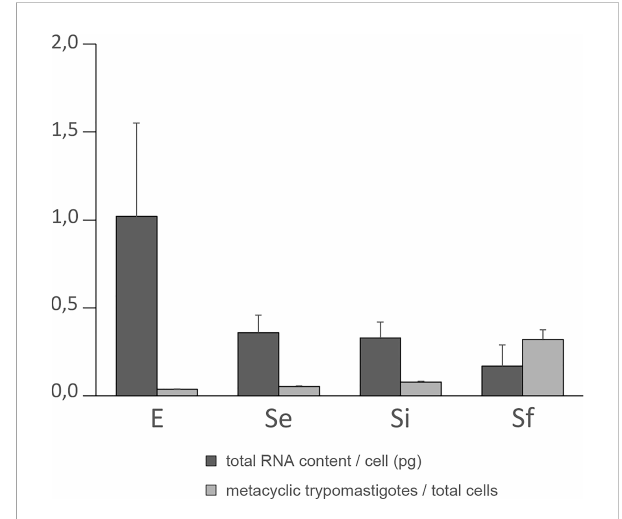
FIGURE 1 Total RNA content/cell and percentage of metacyclic trypomastigote during prolonged cultures of T. cruzi epimastigotes. Total RNA content/cell (pg) and % of metacyclic trypomastigotes of the parasite population of three independent biological replicates for each of the selected points of the epimastigote long-lasting growth curve: exponentially phase (E) and early, intermediate, and fi nal stationary phase (Se, Si, and Sf respectively). Standard errors are